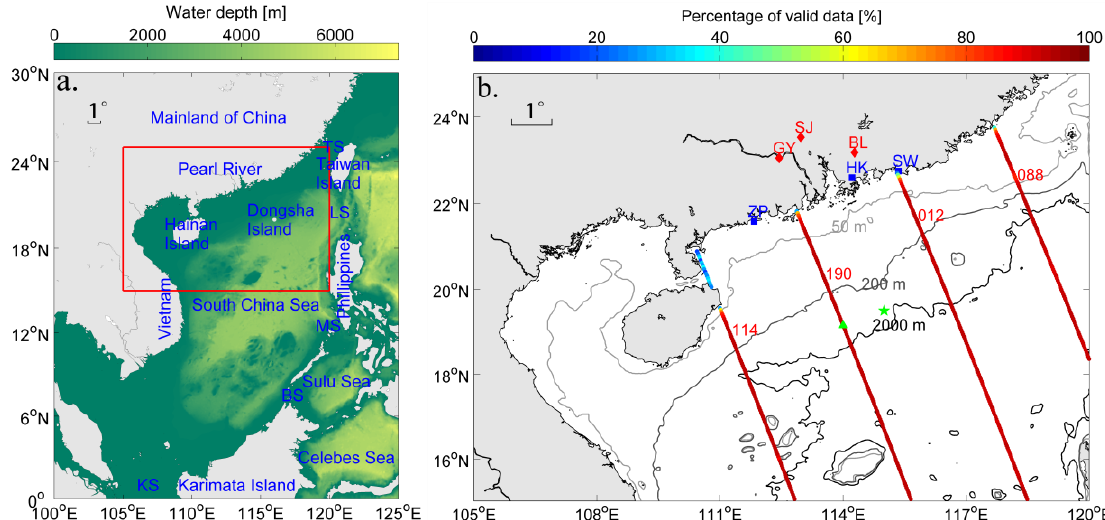
Figure 1. ( a ) Map of the South China Sea (SCS). TS: the Taiwan Strait, LS: the Luzon Strait, MS: the Mindoro Strait, BS: the Balabac Strait, KS: the Karimata Strait; ( b ) Map of the northern SCS (NSCS) and altimeter ground tracks (colored dots). The percentage of valid data along the four ground tracks are shown in different colors and the track numbers are shown in red. The 50, 200, and 2000 m isobaths are shown in light to dark gray. The location of moored acoustic Doppler current profilers (ADCP) is indicated with the green pentagram. The nearest point with ADCP along track 190 used in the validation is shown as a green triangle. The location of tide gauges (TG) are shown as blue squares. SW: Shanwei, HK: Hong Kong, ZP: Zhapo. The three hydrologic stations are shown as red diamonds. GY: Gaoyao, SJ: Shijiao, BL: Boluo.